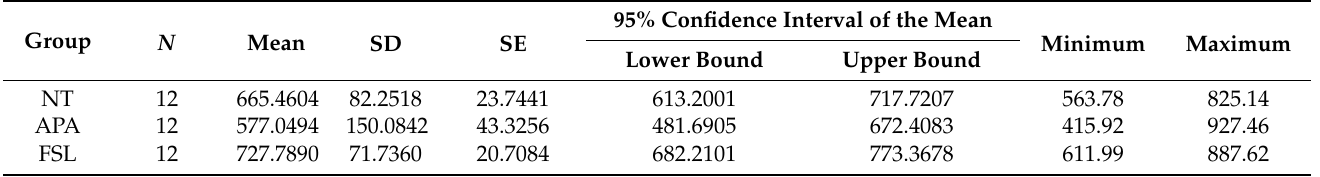
Table 2. Statistical description of the flexural strengths of the three surface treatments (Mpa).